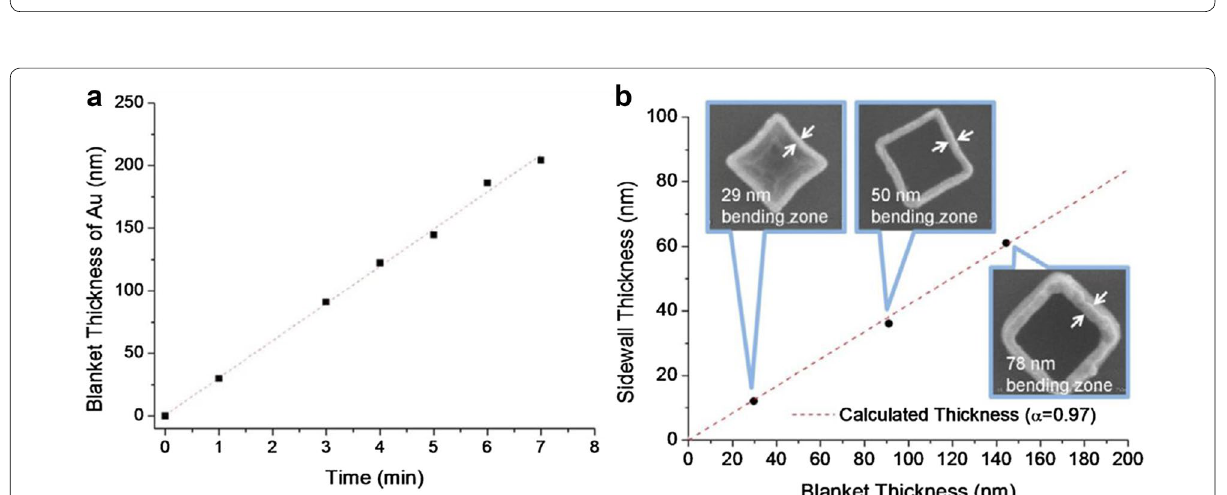
Fig. 4 Changes of a blanket thickness as a function of deposition time and b sidewall thickness as a function of blanket thickness using a 400 nm square pattern. The dashed line indicates the calculated sidewall thickness